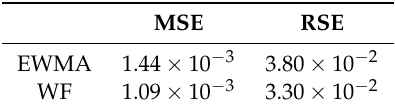
Table 3. Comparison of the two prediction